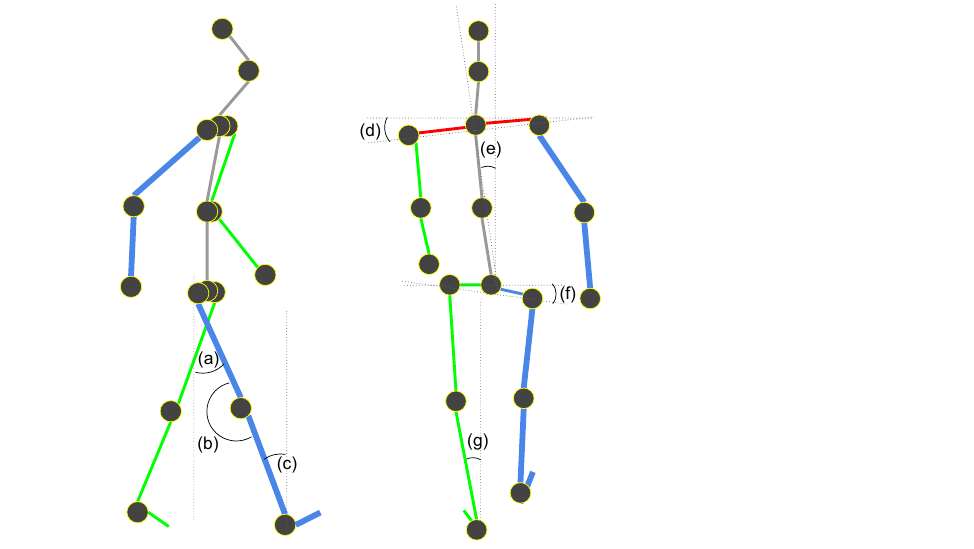
Figure 8. Angle features. ( a ) Hip extension angle, ( b ) Knee flexion angle, ( c ) Leg inclination an- gle, ( d ) Lateral shoulder drop angle, ( e ) Trunk side bending angle, ( f ) Lateral pelvic drop angle, ( g ) Rearfoot eversion